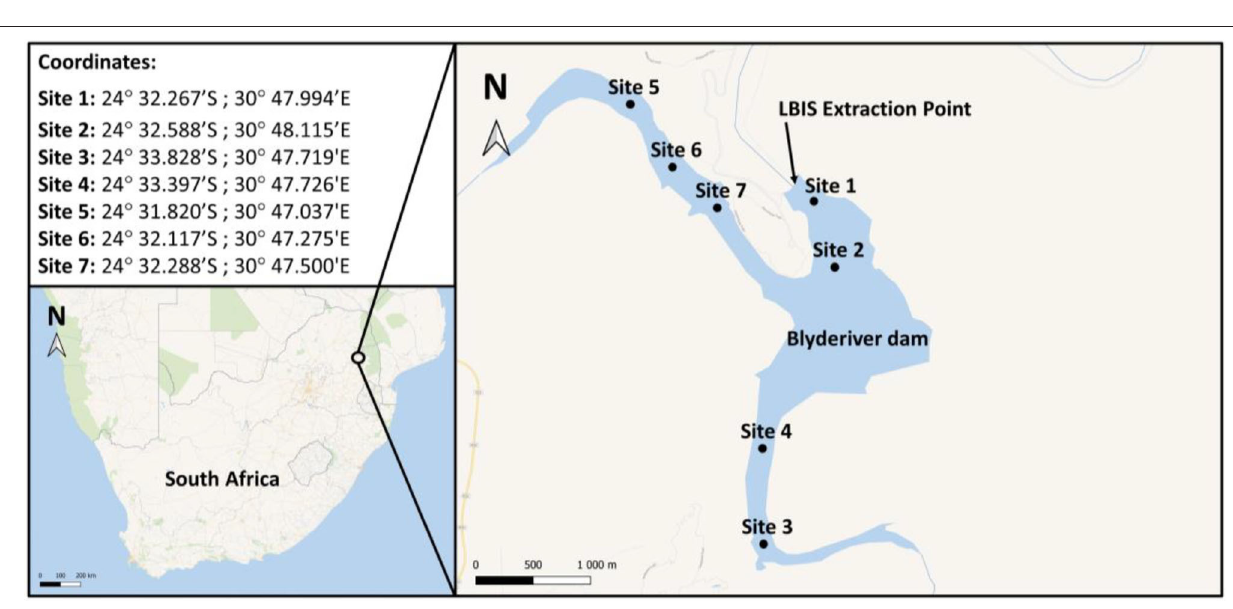
FIGURE 2 | Map and GPS coordinates indicating sampling sites on the Blyderiver dam. Water samples were collected at 1–2m depth intervals. Site 1 is nearest to the wall and extraction point; sites 3 and 5 are the sampling points closest to the influences of the Blyde and Orighstad rivers,